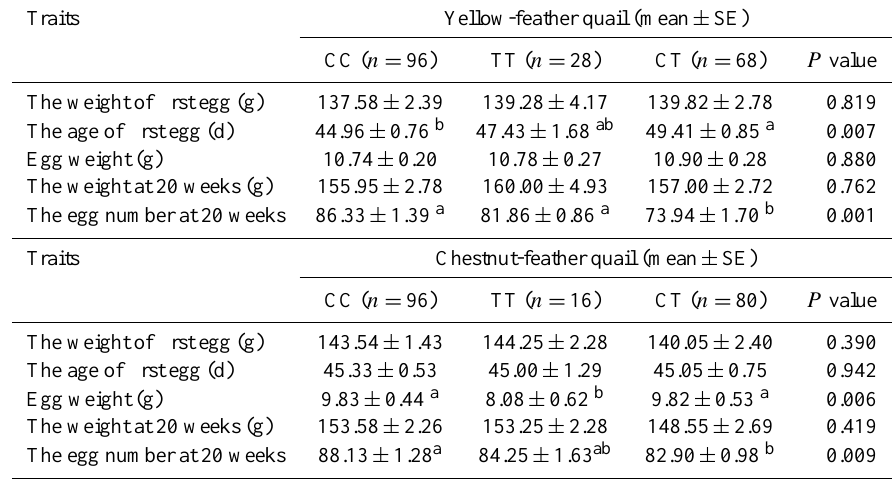
Table 3. Least square means and standard errors of the laying traits in two quail populations. Traits Yellow-feather quail (mean ± SE)